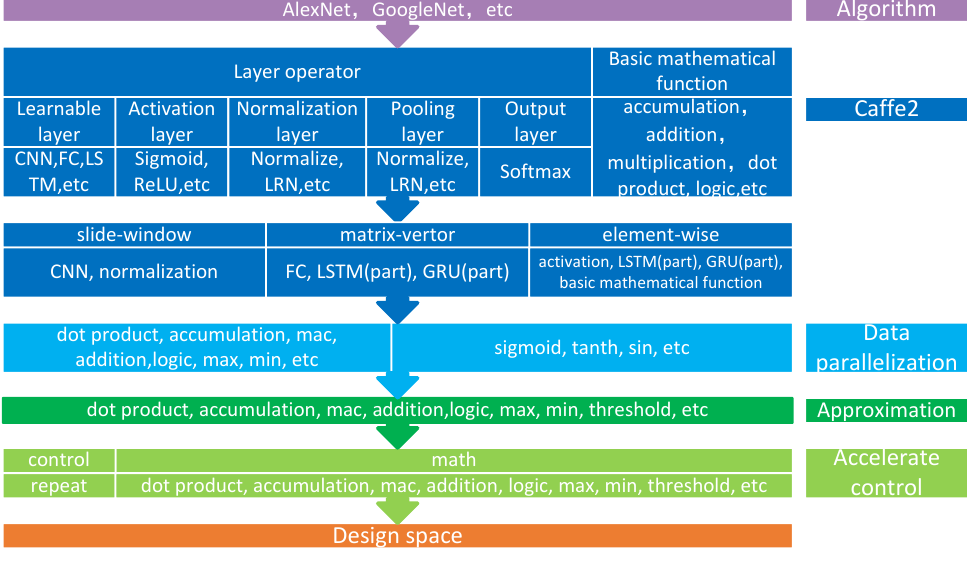
Figure 1. The design space extracted from